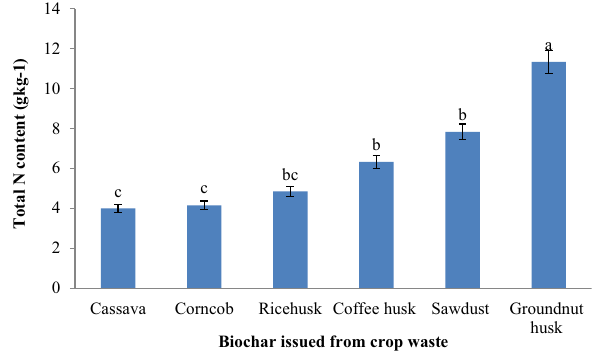
Fig. 5 N content of biochar issued from crop wastes. The letters in superscript compare the mean ± SD of the treatments. The same let- ters on a bar are not significantly different according to Tukey test at P > 0.05 Table 6 Available phosphorus and exchangeable cations content of soil and biochar